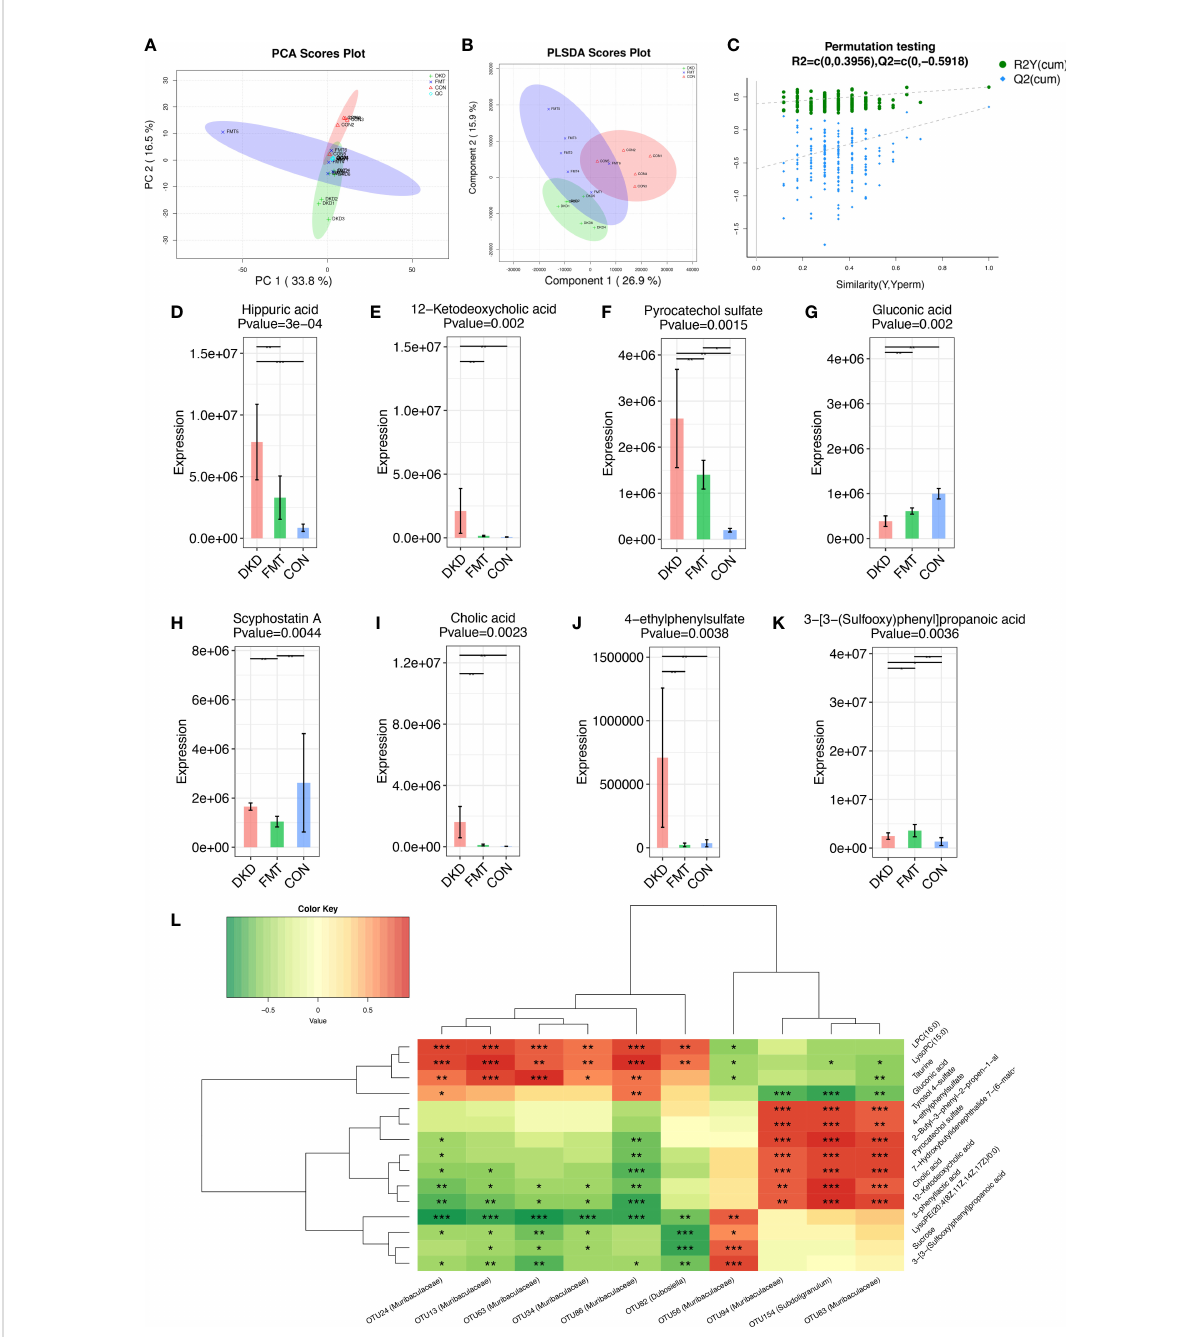
FIGURE 8 Metabolic alterations of mouse models based on untargeted metabolomic detection and Spearman ’ s correlation analysis between important differential metabolites and key OTUs. PCA scores plots (A) and PLS-DA scores plots (B) validated serum metabolites disparity between three groups. Scatter plots of the statistical validations obtained by 200 ’ s permutation tests (C) . The boxplots showing the comparison of the relative expression level of 8 important differential metabolites among three groups (D – K) . The Spearman ’ s correlation relationship between important differential metabolites and key OTUs were presented as heatmap (L) . PCA, principle component analysis; PLSDA, Partial Least-Squares Discrimination Analysis. *p<0.05; **p<0.01;